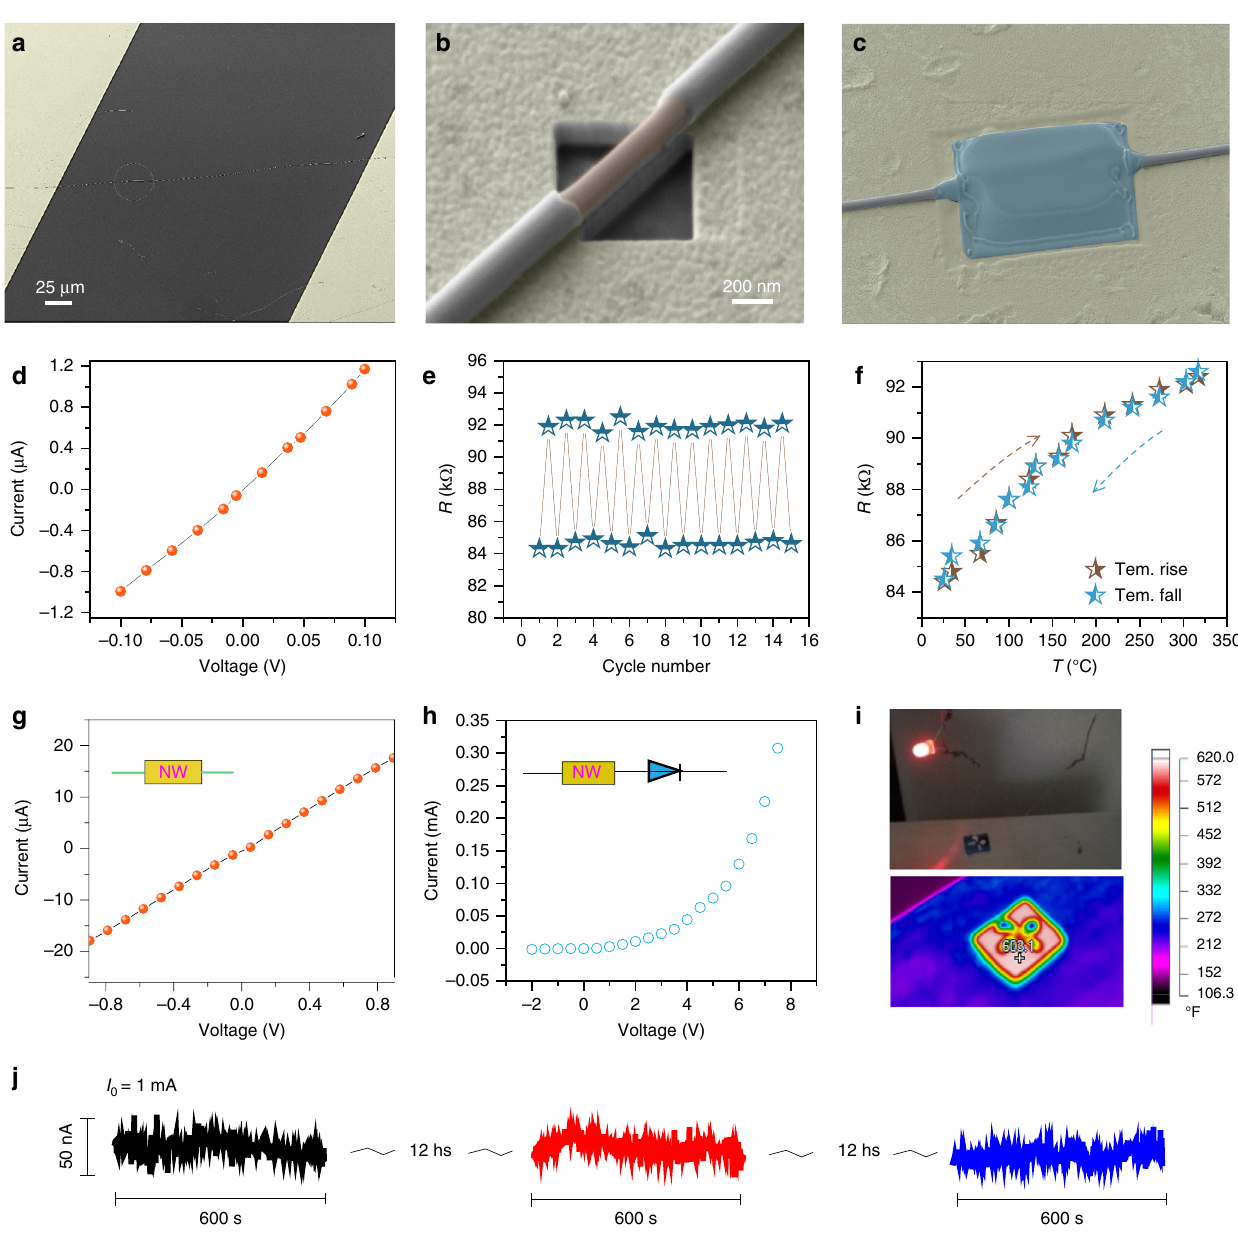
Fig. 4 Resistance investigation at evaluated temperatures of Mn 5 Si 3 @SiO 2 nanocables. a The real device with 250 um channel length for experiment. b The electrode region after FIB radiation with Mn 5 Si 3 core naked. c After Pt/C deposition and connection to Au patterns. d The I – V curve acquired. e The recorded resistances as the temperature switching between 317 °C and 26 °C. f The resistance-temperature dependence at a range of 26-317°C. g The I – V curve of another device used for long-time stability investigation at ~300 °C. h The I – V curve of the device incorporating a red LED light. The insets show the illustration of the nanowire connection. i The optical picture of the circuit (upper) and thermal imaging of the device substrate (bottom). j the long-time stability investigation at 300